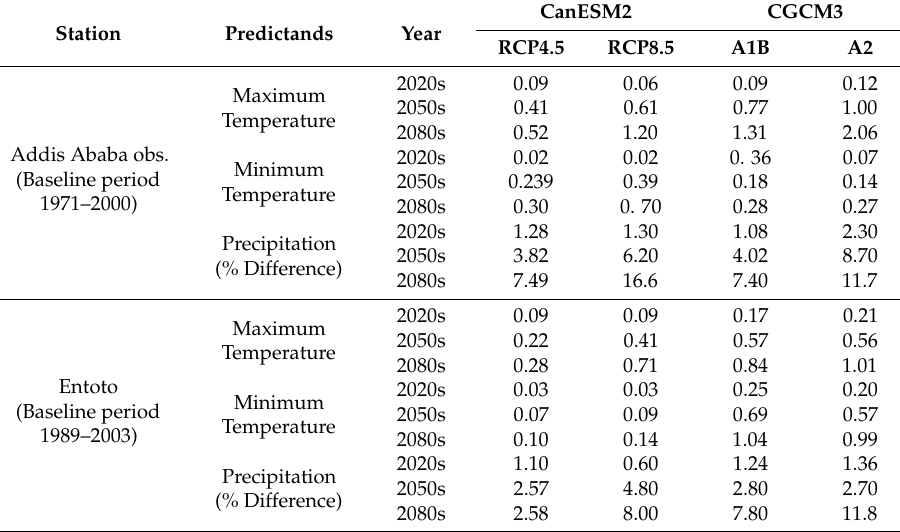
Station Table 4. Downscaled temperature (°C) and precipitation (%) scenarios (changes). Station